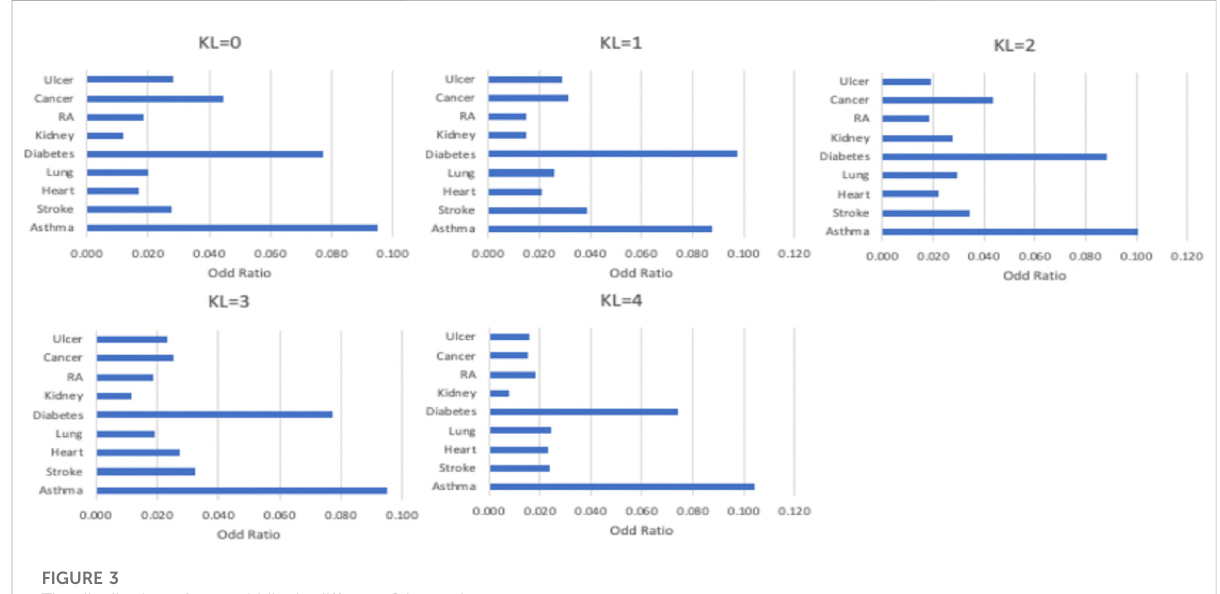
FIGURE 3 The distribution of comorbidity in different OA severity.